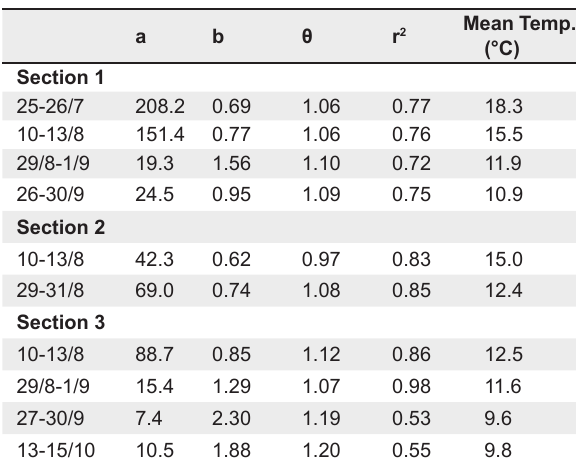
Table 3. Linear regression on log-transformed data using Eq. 1; r 2 is the determination coefficient, and a, b, θ are constants. Also shown is the mean water temperature during the periods (for variation see Table